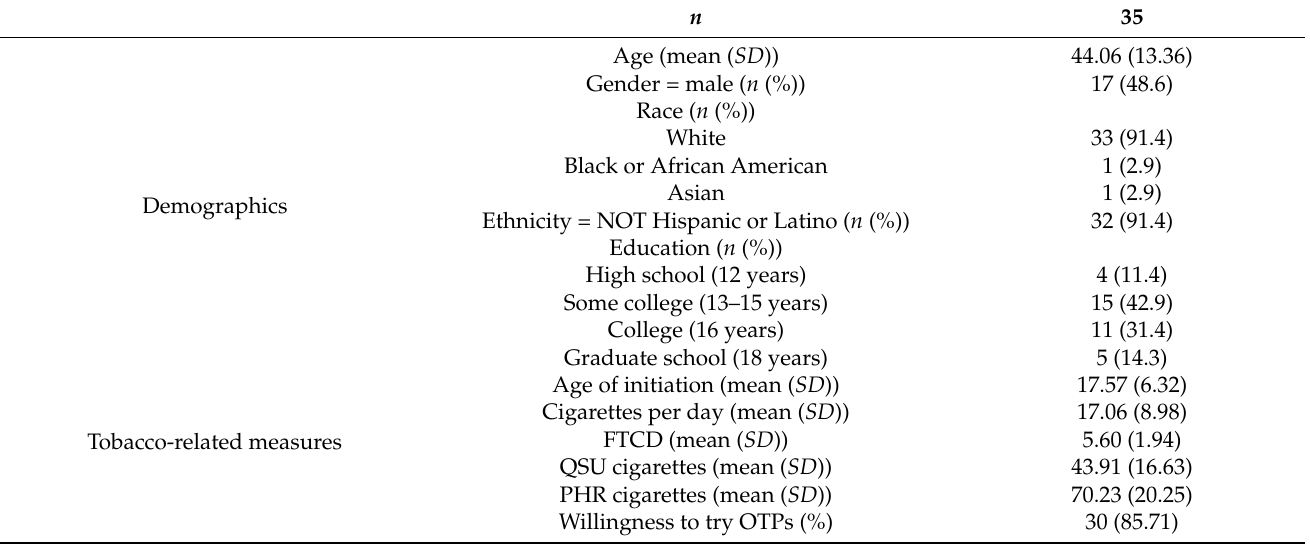
Table 1. Demographic characteristics and tobacco-related measures’ means, standard deviations, and